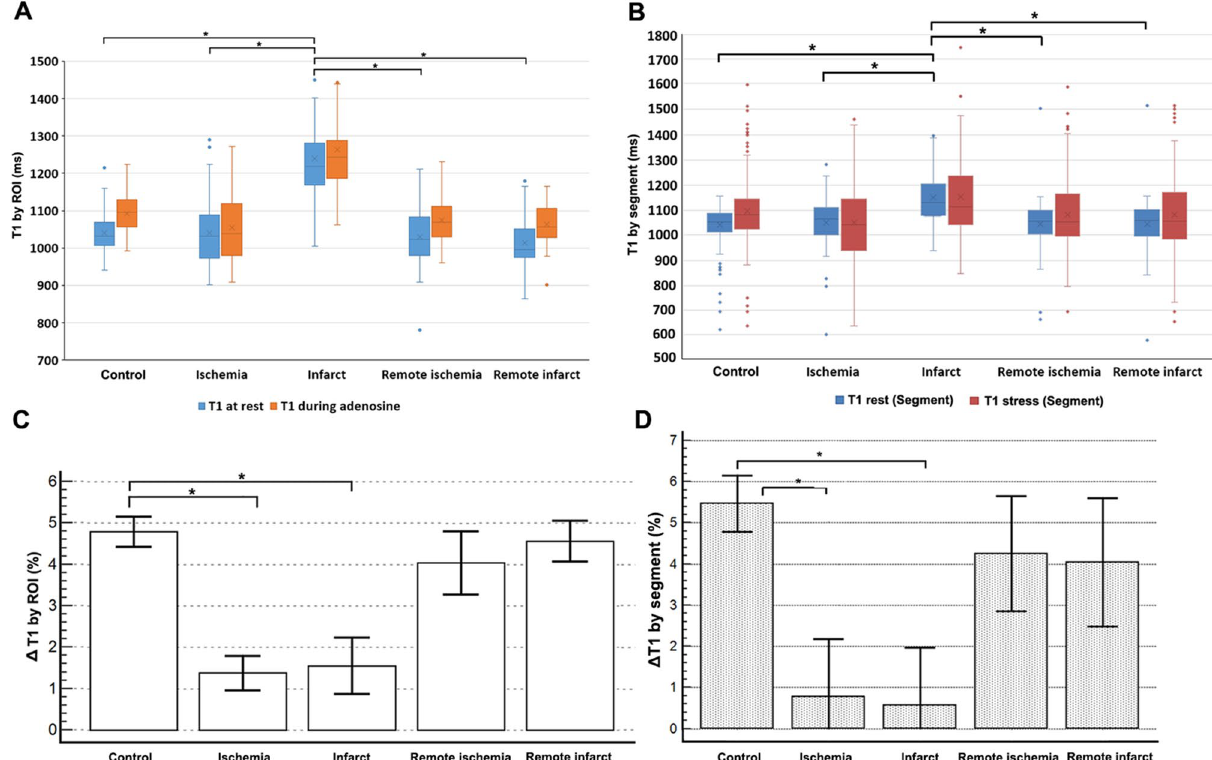
Figure 4. Myocardial T1 at rest and during adenosine stress in ROI ( A and C ) and per-segment ( B and D ) analysis. Both absolute values (T1 in ms, A and B ) and percentage differences (ΔT1 in %, C and D ) were shown for different groups. * p <